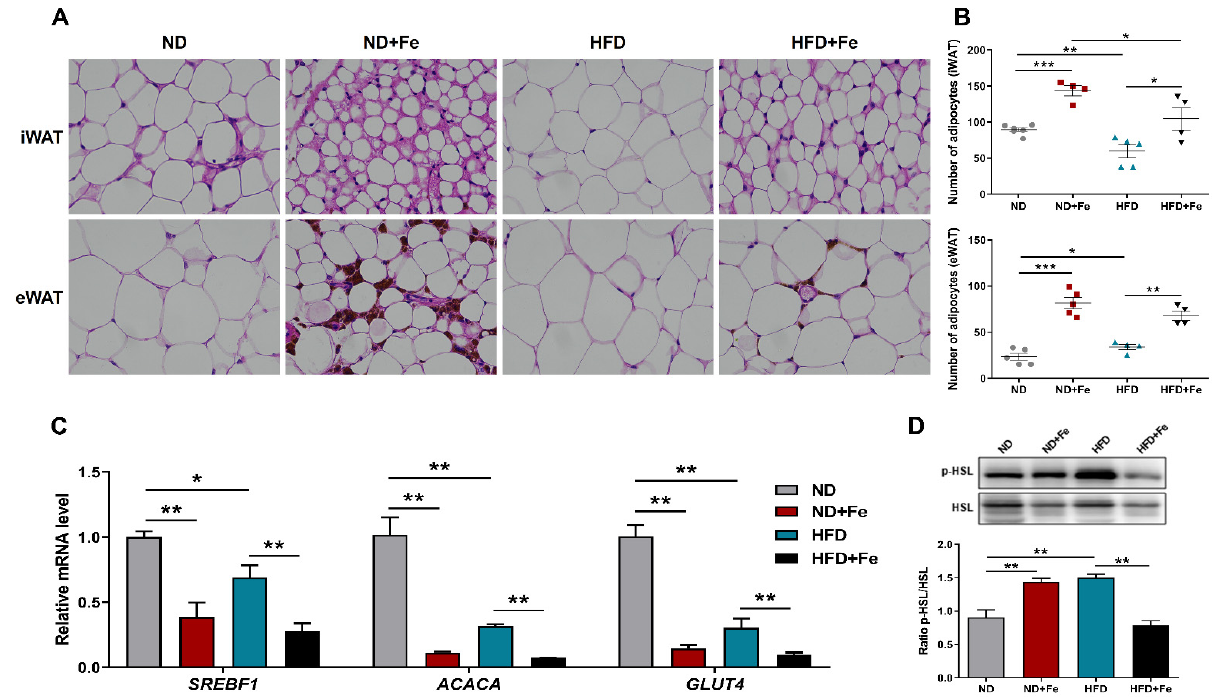
Figure 2. Reduced adipocyte hypertrophy due to iron overload. ( A ) Representative images of iWAT and eWAT fat pad sections stained with H&E; ( B ) Number of adipocytes of iWAT and eWAT; ( C ) Relative gene expression of SREBF1, ACACA and GLUT4 in eWAT samples; ( D ) Western blot analysis of phosphor-HSL and total HSL protein expression and their quantification in liver samples. ND ( n = 6), ND + Fe ( n = 7), HFD ( n = 7), and HFD + Fe ( n = 8). The values are the means ± SEMs. * p < 0.05, ** p < 0.01, *** p < 0.001. Significant differences between two groups were analyzed with the two-tailed Student’s t test.